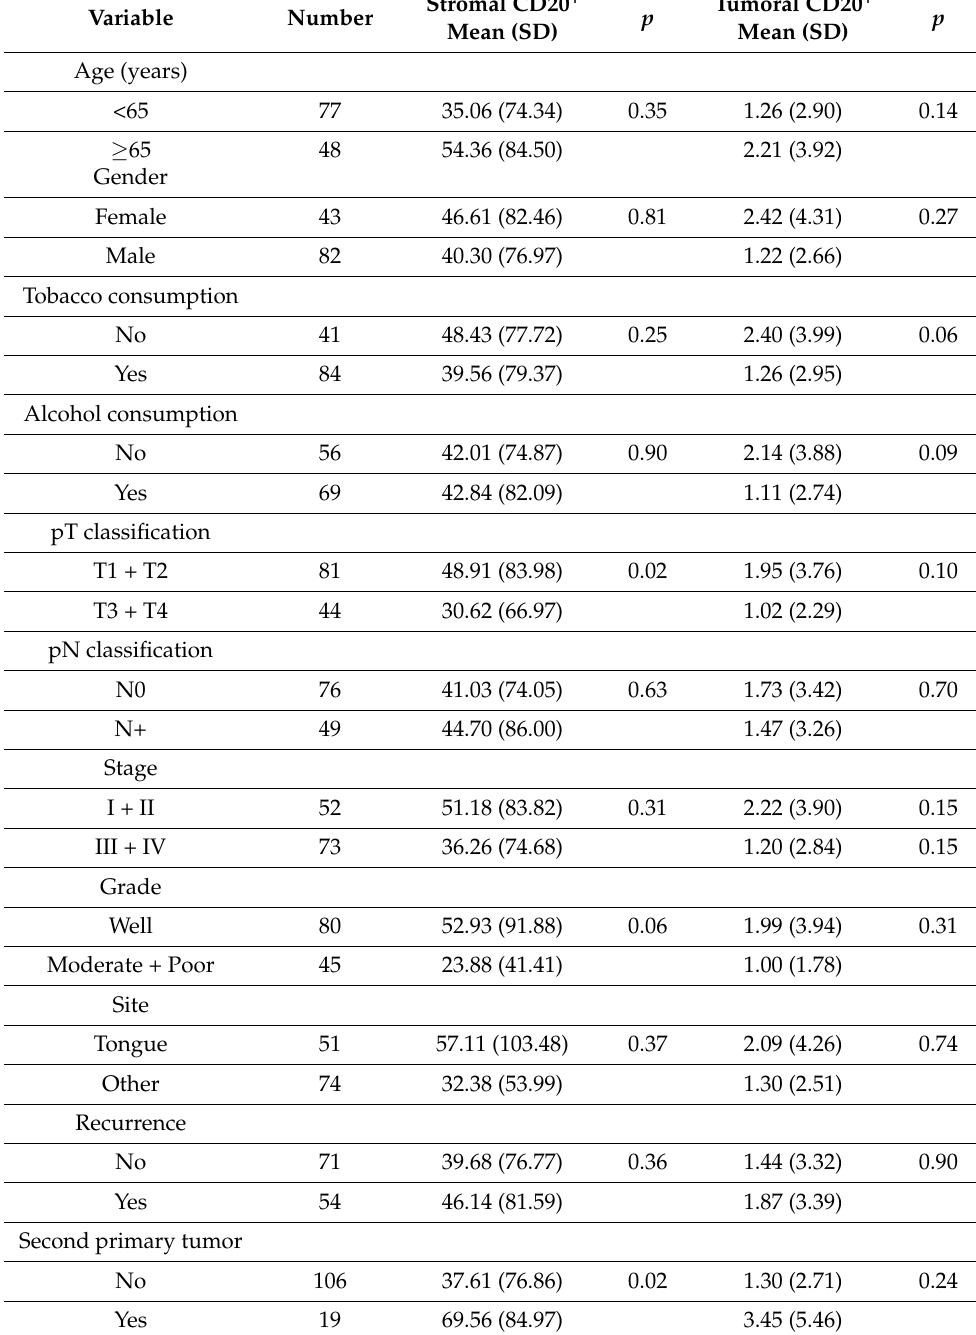
Table 2. Associations between stromal/tumoral CD20 + B infiltration and the clinicopathological parameters in the cohort of 125 OSCC